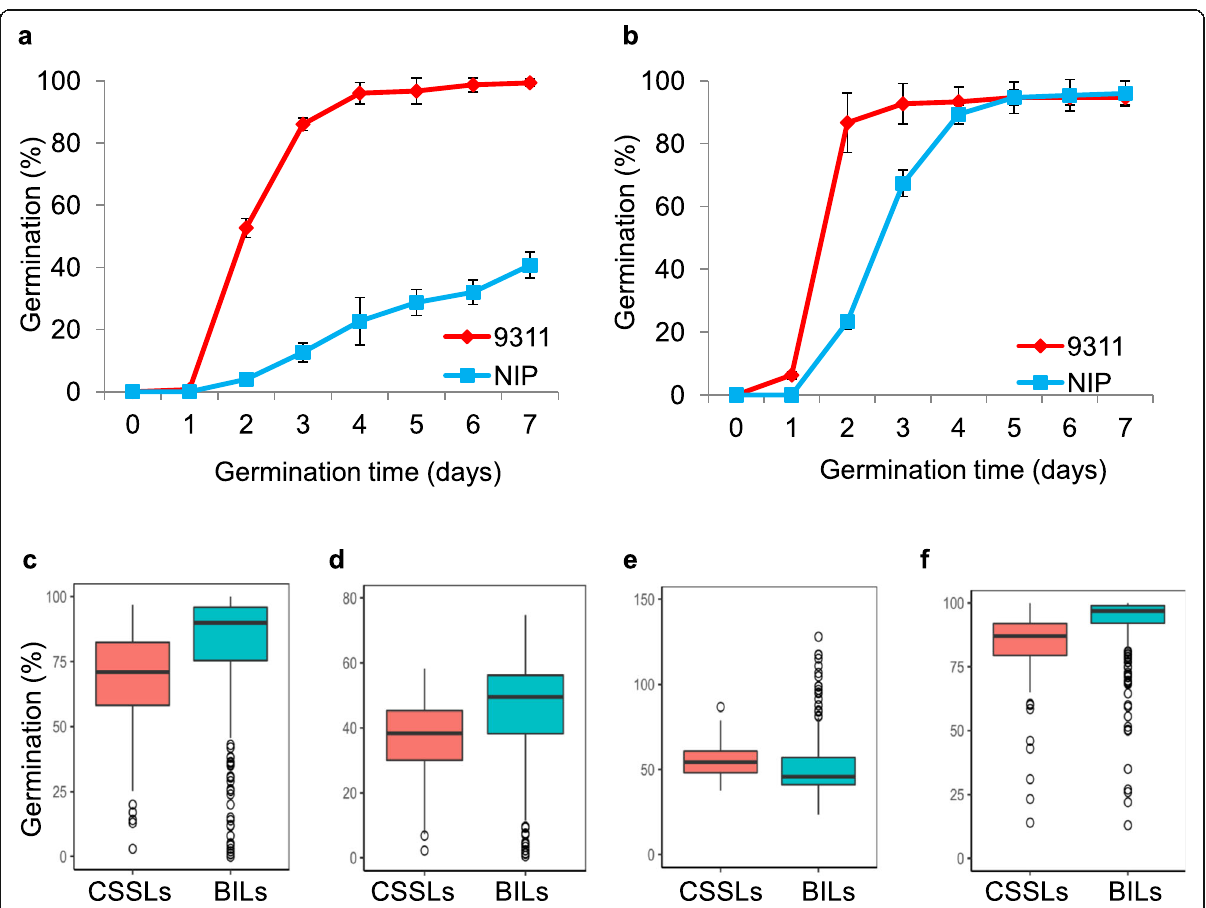
Fig. 1 Differences in seed dormancy between Nipponbare (NIP) and 9311 and among chromosome segment substitution lines (CSSLs) and backcross inbred lines (BILs). a Germination curve of the freshly harvested seeds of NIP and 9311. b Germination curve of NIP and 9311 after seed dormancy was broken. The error bar represents the mean ± SD ( n = 3). Boxplots of G 3d ( c ), AUC ( d ), T 50 ( e ), and G 7d ( f ) in CSSLs and BILs. Box edges indicate the range of the 25th to 75th percentiles, with the median value shown by the bold middle line. Whiskers represent the range of 5% to 95% of the data, and outer dots are outliers. G 3d , germination rate at 72 h after imbibition; G 7d , maximum germination rate at 168 h after imbibition; T 50 , germination speed, which is the time to reach 50% germination of seeds; and AUC, the area under the curve up to 168 h after